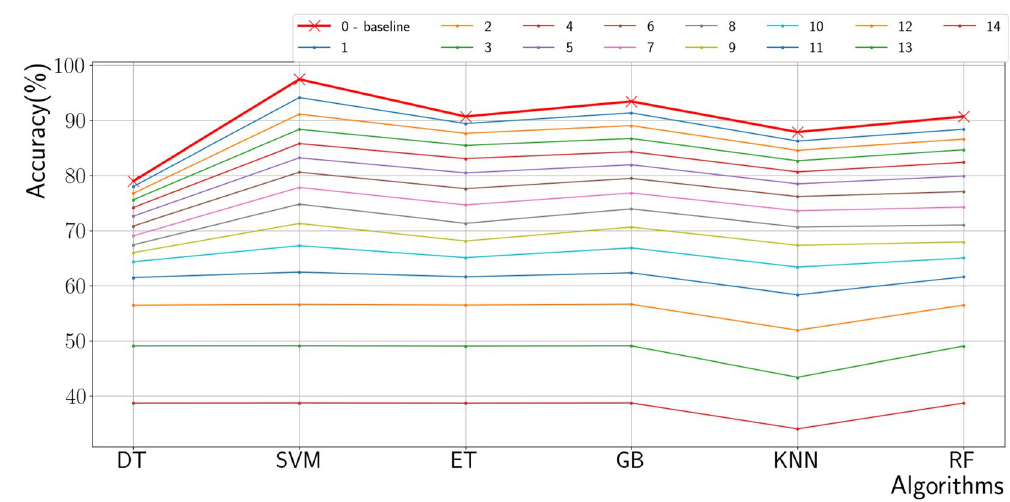
Figure 6. Machine learning-based classifier